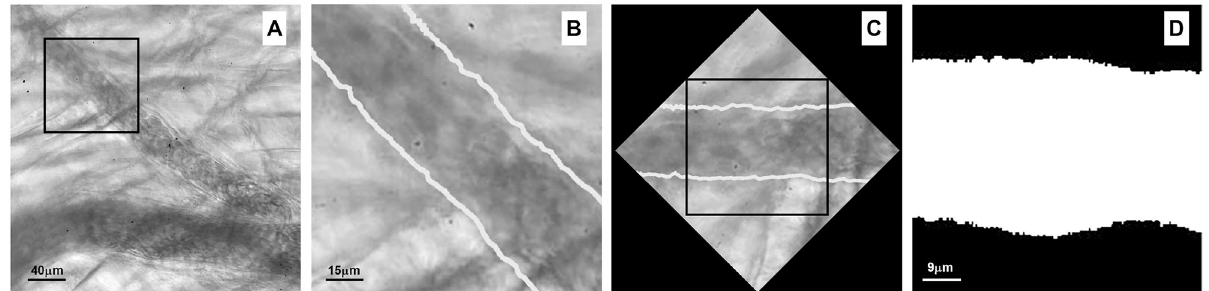
Fig 6. Measurement of the arteriole diameter. (A) To measure the diameter of arteriole, a sub-image of 100 x 100 pixels was generated (black square). (B) In this new image, the vessel wall was highlighted in white. (C) The Hugh transform was applied, and the image rotated to horizontal position. (D) The arteriole diameter was calculated in the binarized image.